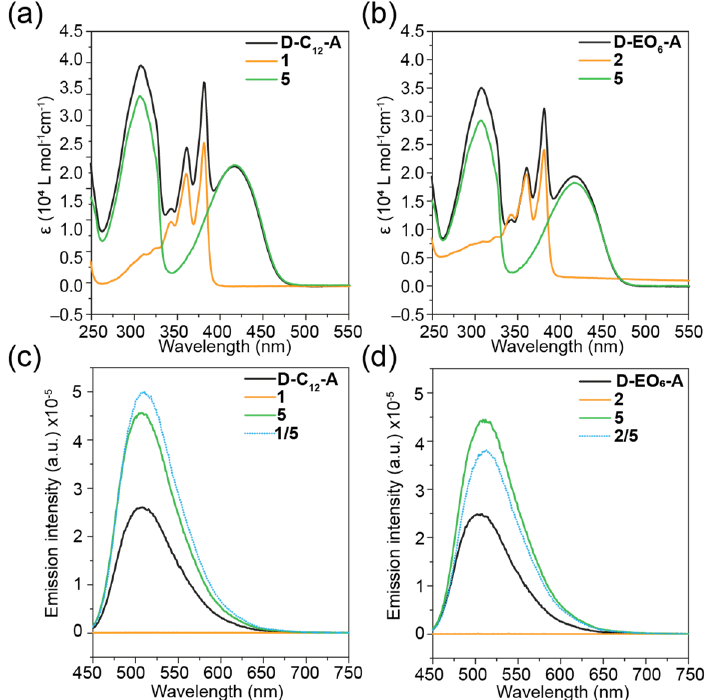
Figure 3. ( a , b ) Comparison of the UV-vis absorption spectra of ( a ) D-C 12 -A , 1 , and 5 and ( b ) of D- EO 6 -A , 2 , and 5 . ( c , d ) Comparison of the fluorescence spectra of ( c ) D-C 12 -A , 1 , 5 , and an equimolar mixture of 1 and 5 and (d) of D-EO 6 -A , 2 , 5 , and an equimolar mixture of 2 and 5 . All spectra were recorded in a mixture of CHCl 3 and MeOH (99.5:0.5 v / v %) and the concentration of all dyes was 10 µmol L − 1 . All emission spectra were recorded with excitation at a wavelength ( λ ex ) of 417 nm.